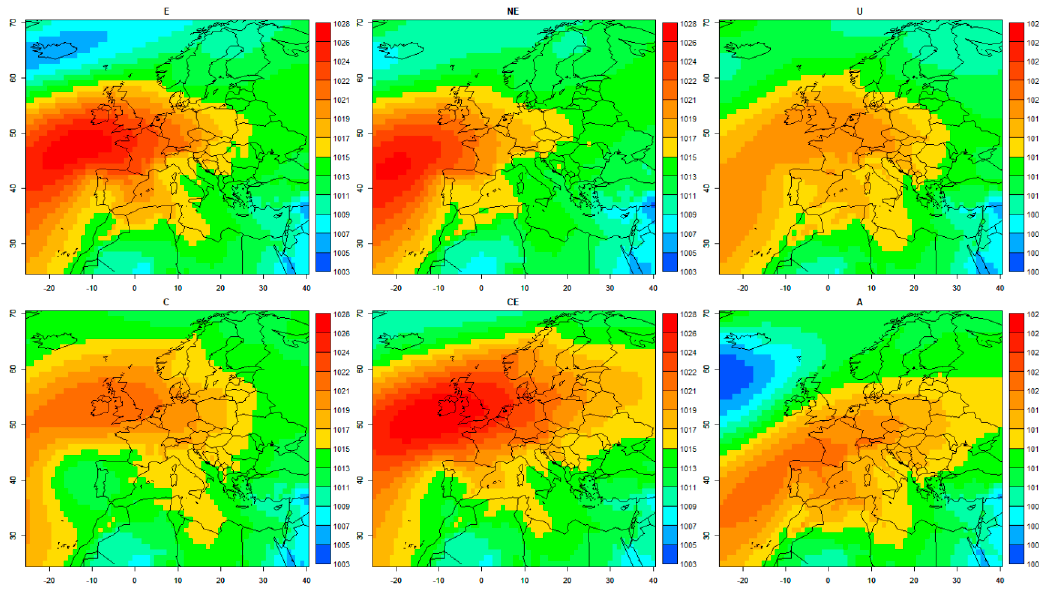
Figure 5. Weather types (mean sea level pressure in hPa) relevant for ozone and heat waves in Portugal. E: East (mean relative frequency across all wave types: 24.4%), NE: Northeast (15.2%), U: “unclassified” weather type (15%), C: Cyclonic (7.8%), CE: Cyclonic East (6.7%), A: Anticyclonic (5.7%).